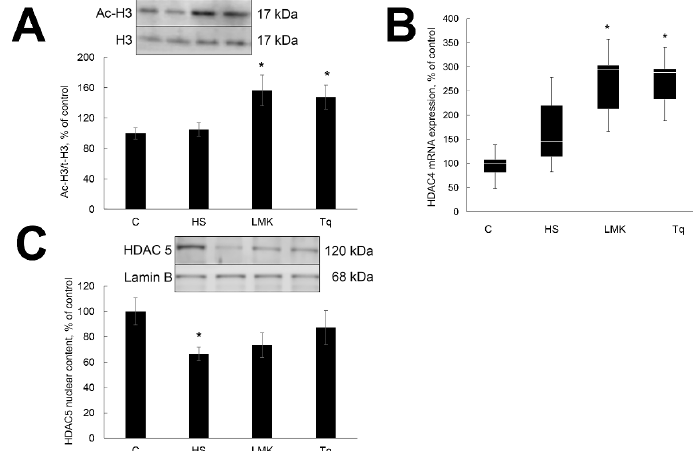
Figure 1. Evaluation of acetylated histone H3 content ( A ), histone deacetylases (HDAC) 4 mRNA expression ( B ) and HDAC 5 nuclear content ( C ) in soleus muscles of nontreated control rats ( C ), rats after 3 days of unloading (HS), 3 days HS with LMK-265 inhibitor (HSLMK) or HS with Tq inhibitor (HSTq). Values are normalized to the levels of total histone H3 ( A ) or Lamin B1 ( C ) in each sample. Levels of HDAC 4 mRNA were normalized to the levels of GAPDH in each sample ( B ). n = 8. * indicates a significant di ff erence from the control, p <